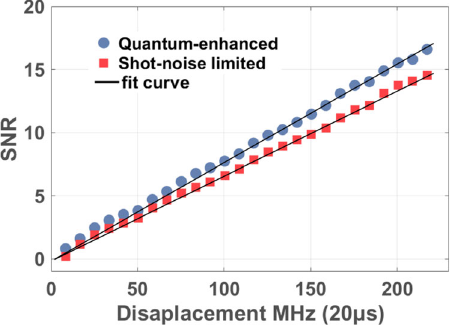
Fig. 3 Signal-to-noise ratio (SNR) measurements. Measurement of the central frequency displacement that is induced inside the laser cavity. The blue and the red lines are the SNRs for the shot-noise limited and quantum-enhanced cases, respectively. All the measure- ments are implemented at 1.5 MHz modulation sideband where all the classical noises could be ignored. All the data are only corrected for electric dark noise. The measurement time is taken to be 20 μ s for each measurement, which is de fi ned by the bandwidth (50 kHz) of the low-pass fi lter. The error bar for each point above is less than 2%, as the system is well locked and many events are used in the measurements. These quantities of the error bars are small, and are thus not drawn for